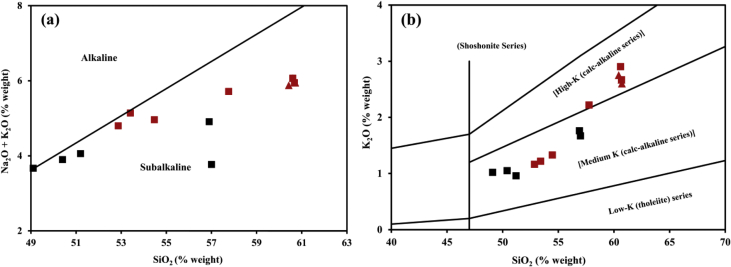
Magma series identification using (a) Plot of Na2O and K2O contents against SiO2 content in a TAS diagram from Ref. [5] and (b) Plot of K2O contents against SiO2 content in a magma series identification scheme from Ref. [7].